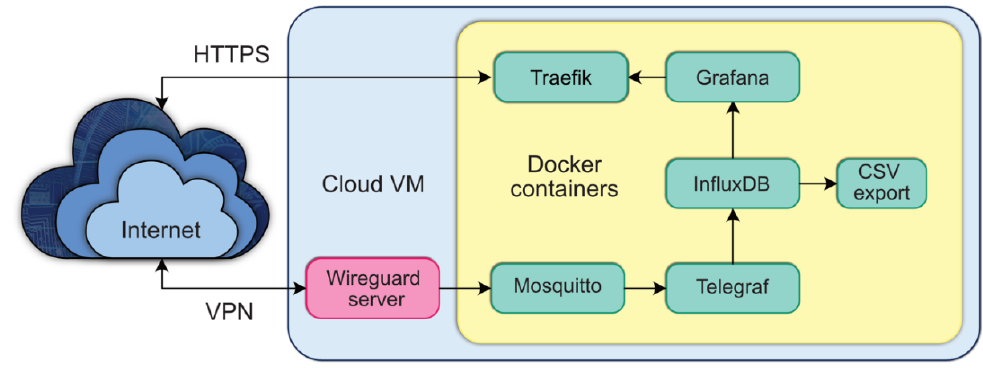
Figure 6. Overview of the server configuration.